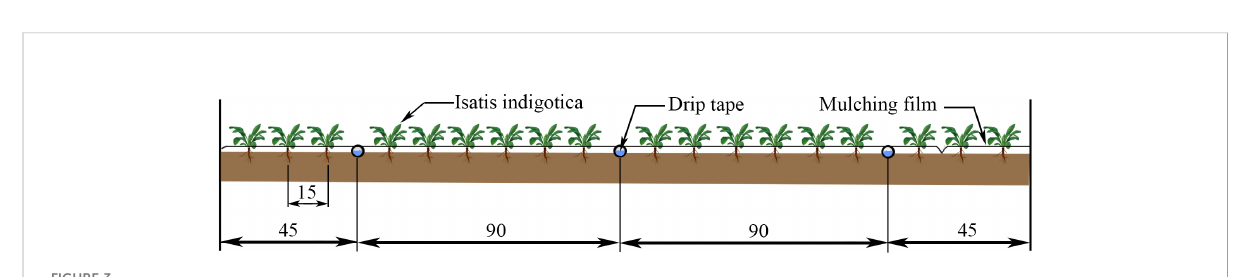
FIGURE 3 Layout of the experimental design mulched drip irrigation. The numbers unit is